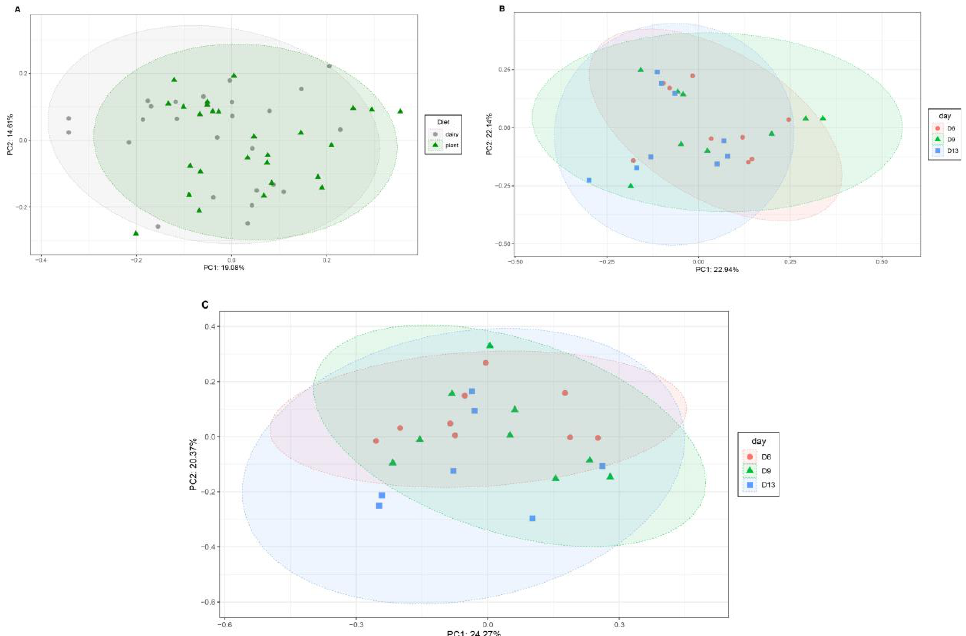
Figure 3. Fecal bacterial diversities between the plant-based and dairy-based formula-fed